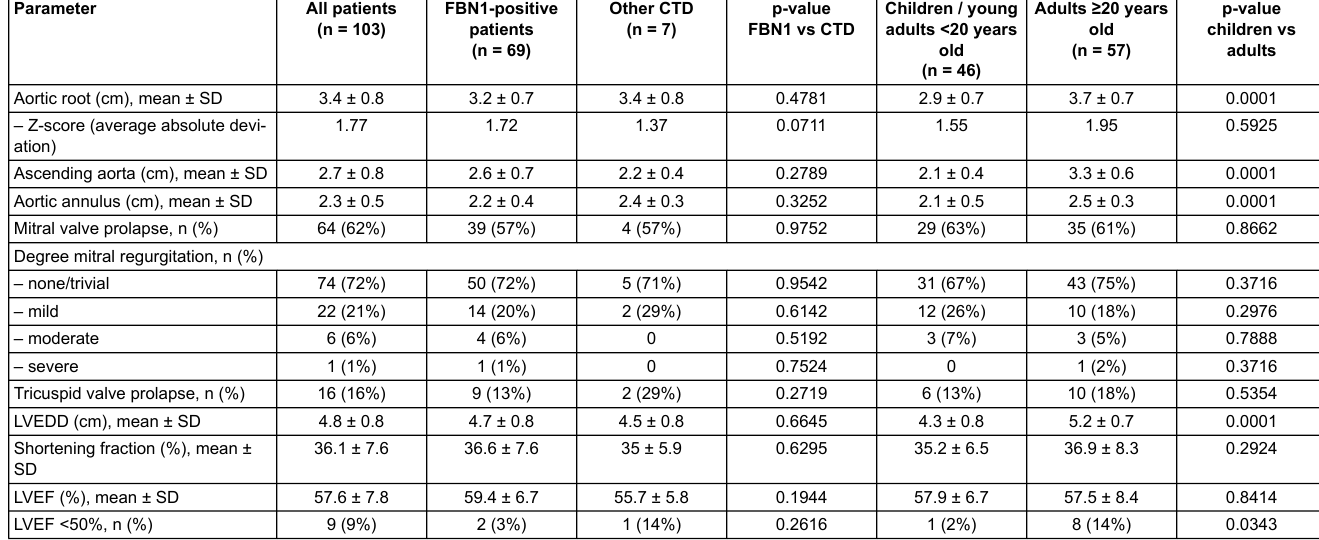
Table 4: Echocardiographic findings.